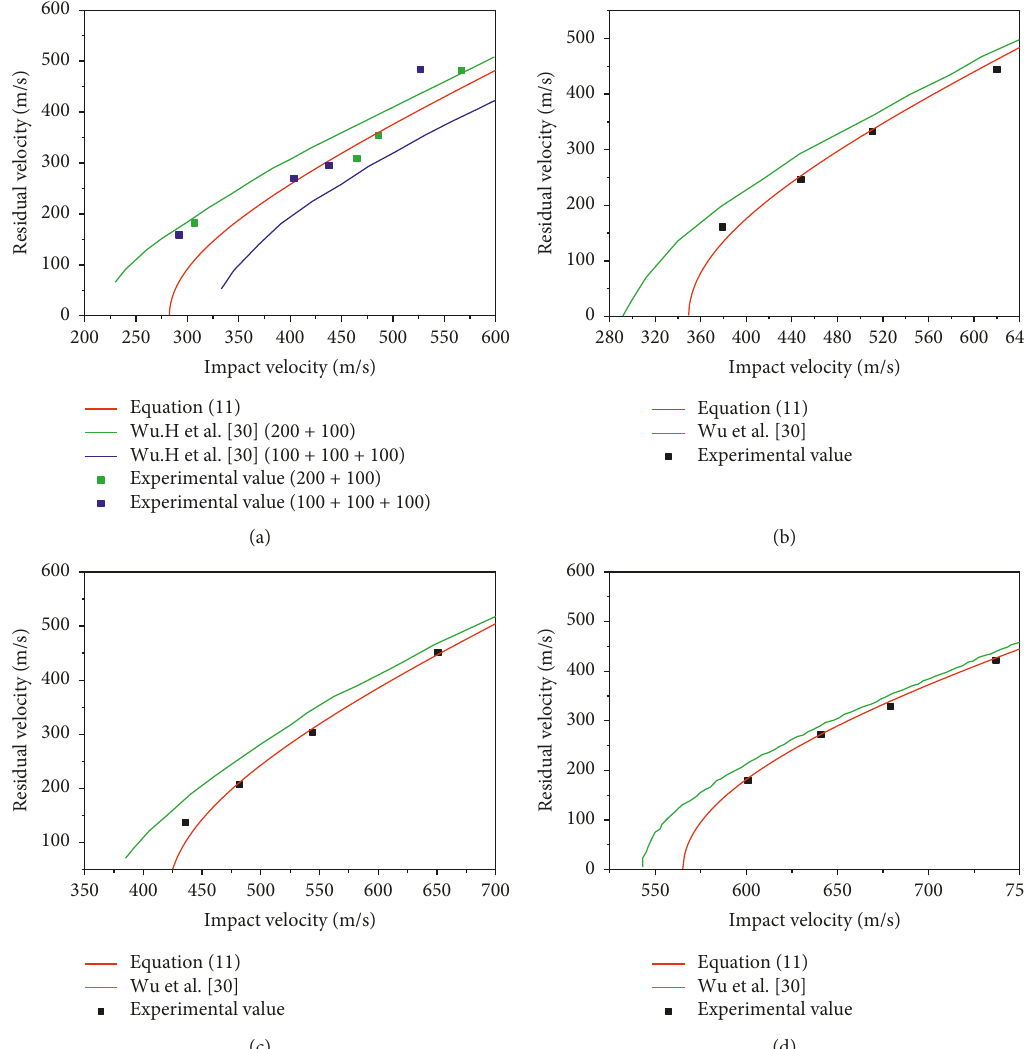
Figure 6: Comparison between the proposed prediction model and an existing one [30] for the projectile residual velocity under different concrete thicknesses. (a) 100mm. (b) 150mm. (c) 200mm. (d)